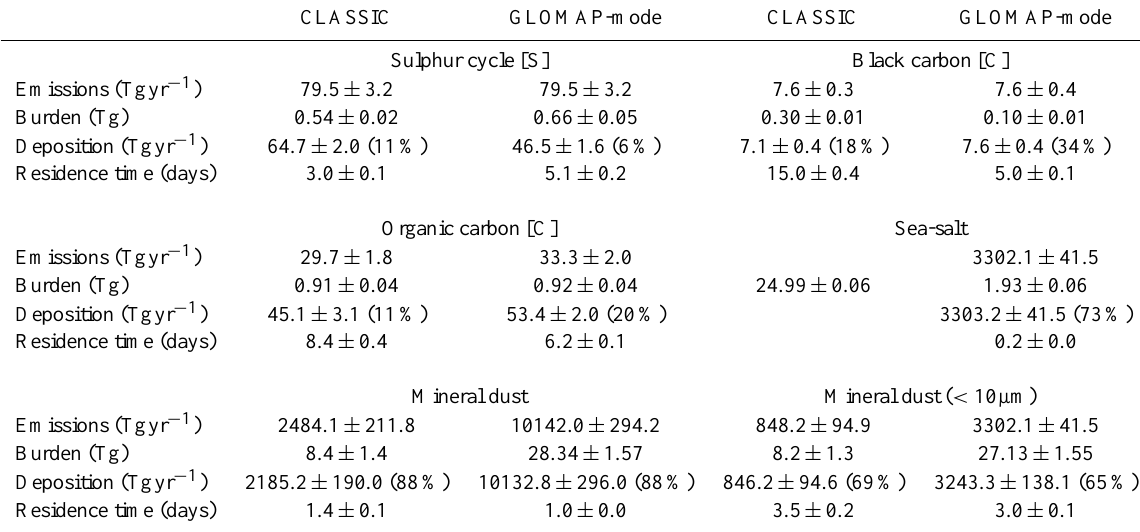
Table 2. Key parameters of simulated aerosol distributions using CLASSIC and GLOMAP-modes aerosol schemes in hindcast simulations of 2000–2006. Sulphur-cycle emissions are for sulphur dioxide, but remaining variables are for sulphate aerosols. For deposition rates, numbers in brackets give the percentage due to dry deposition. CLASSIC sea-salt aerosols are not transported tracers and are not emitted nor deposited. Standard deviations measure the variability over the 2000–2006